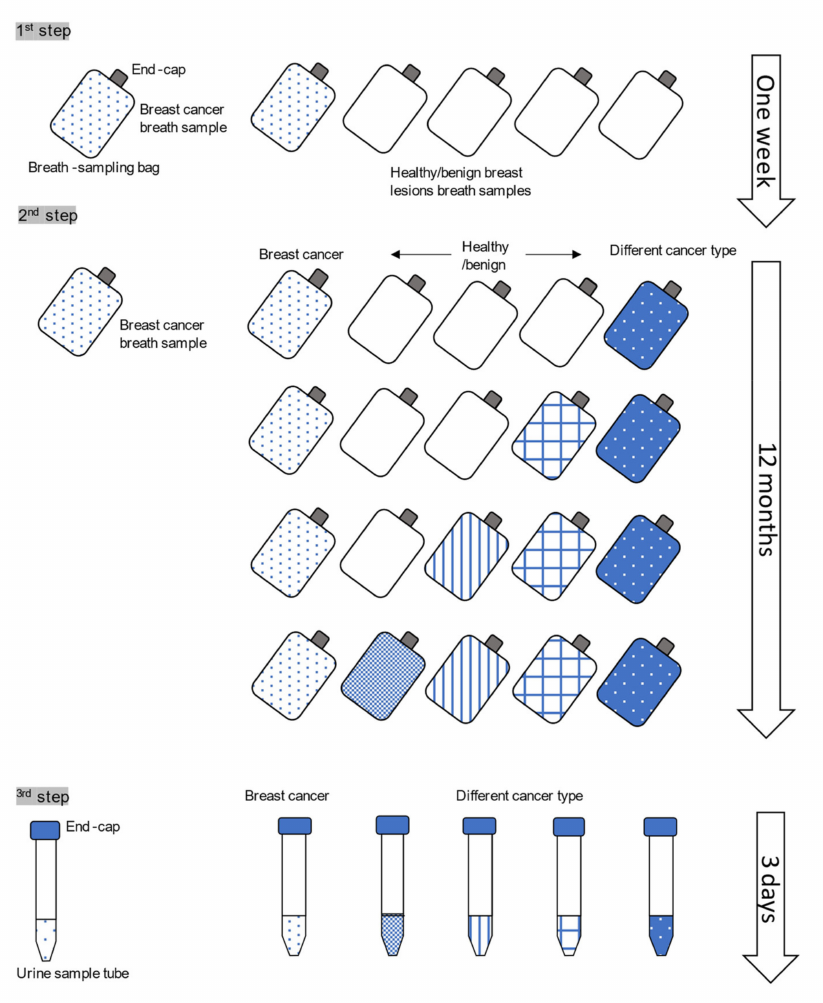
Figure 1. The training steps of the dog. The training consists of the three steps. In the first step, the dog was trained to detect the breath sample bag of the breast cancer patient from one breast cancer and four healthy/benign breast lesion controls. In the second step, the controls consisted of other cancer type and healthy/benign breast lesion controls. In the third step, the training was performed using the urine